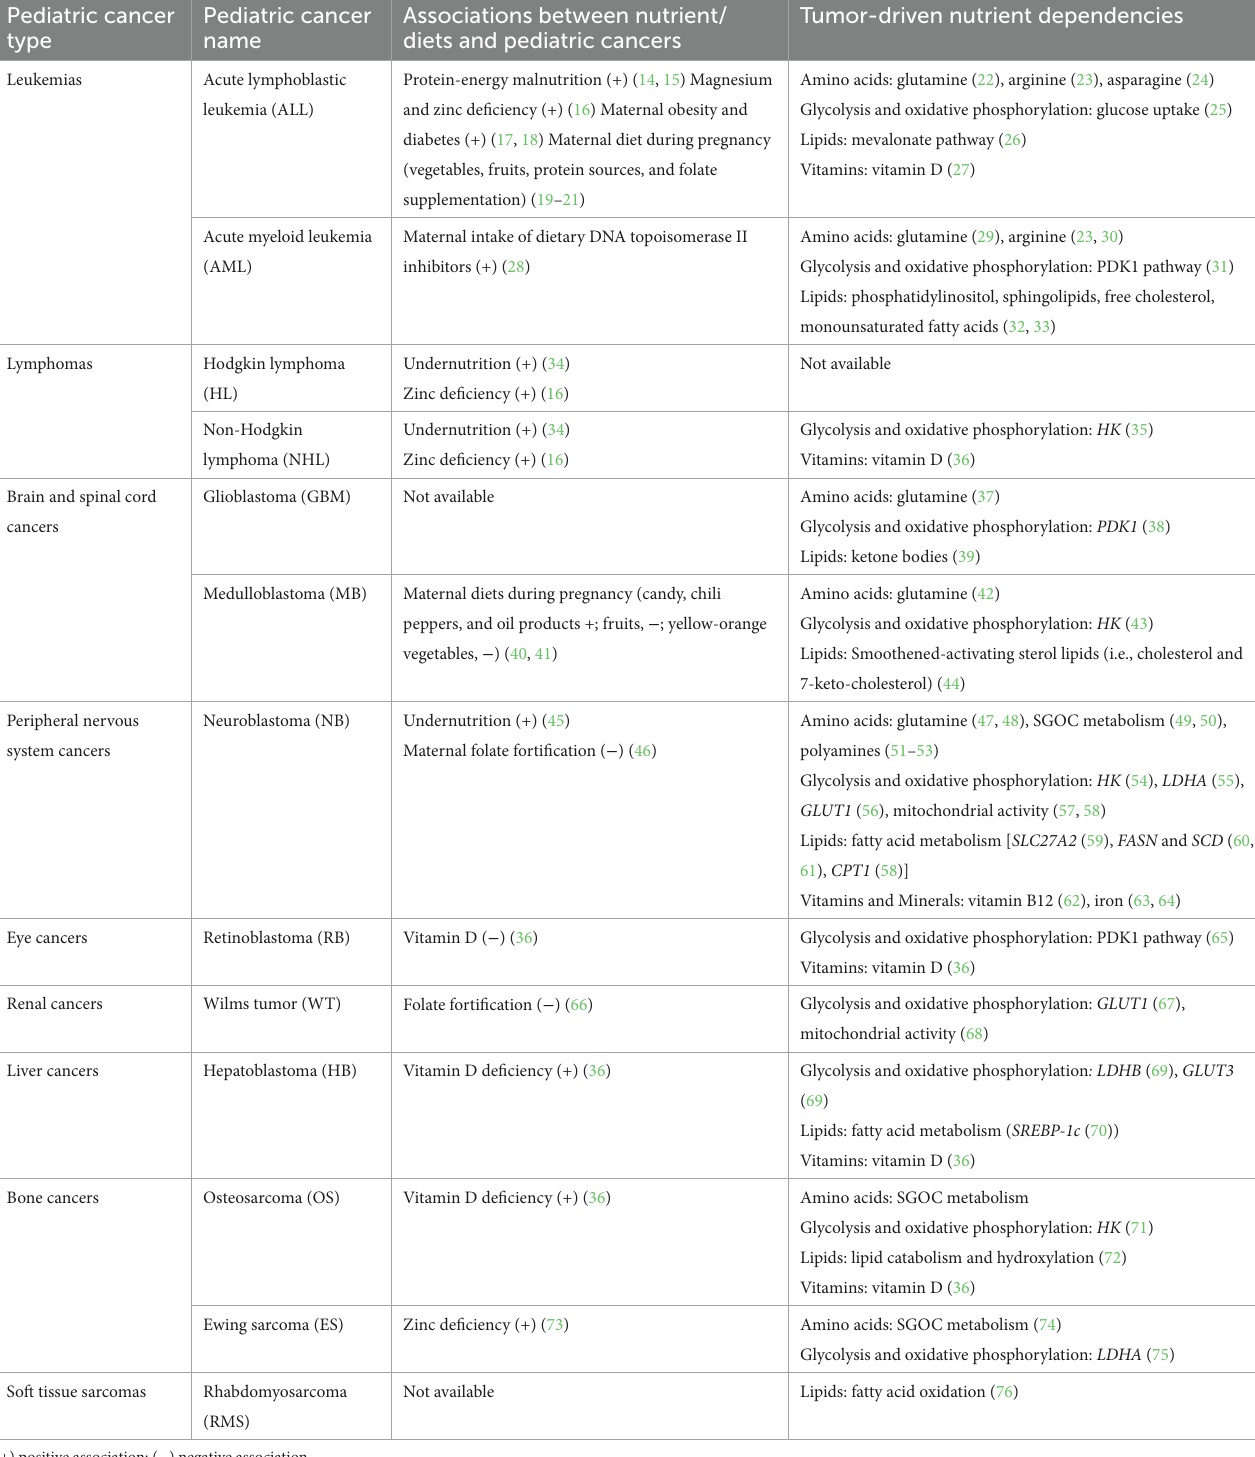
TABLE 1 Dietary associations and tumor-driven nutrient dependencies in pediatric cancers. Pediatric cancer